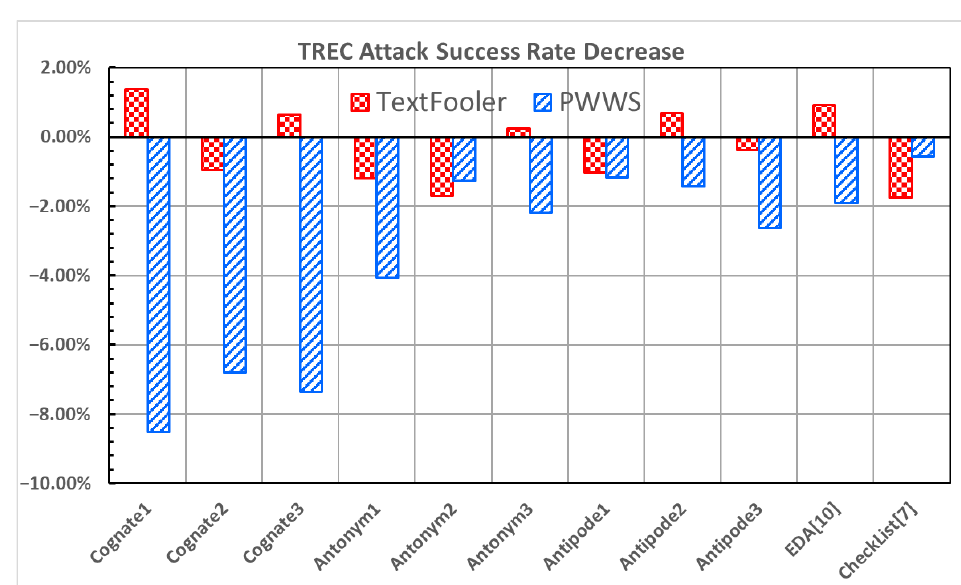
Figure 8. TREC Attack Success Rate Decrease.